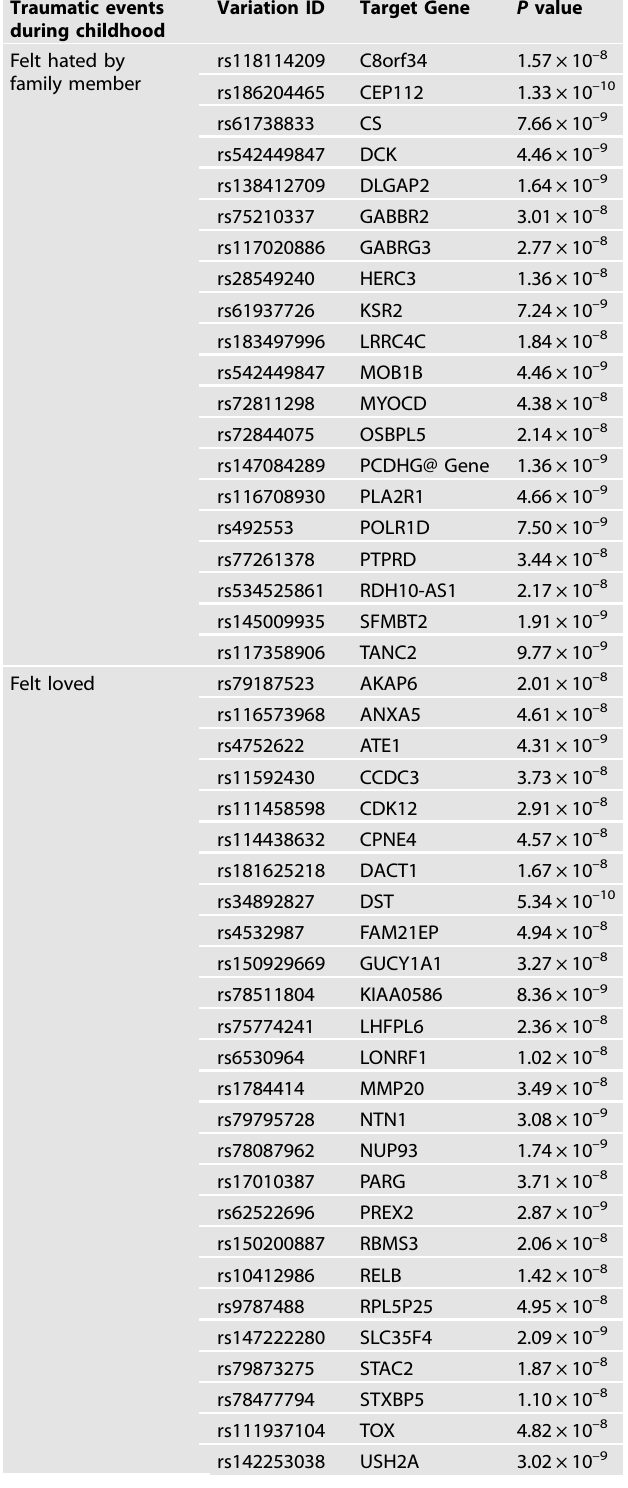
Table 3. The summary of the genetic variants interacting with traumatic events during childhood in the frequency of alcohol